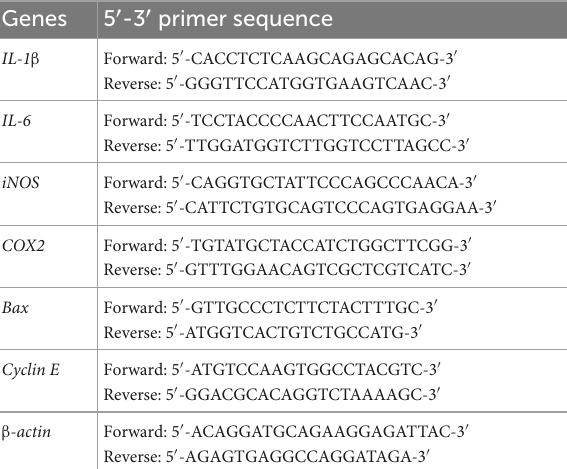
TABLE 1 Primer lists for RT-PCR (32,